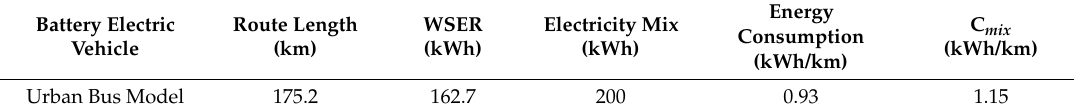
Table 14. Detailed results from the urban electric bus and its connection in the Spanish electricity mix.